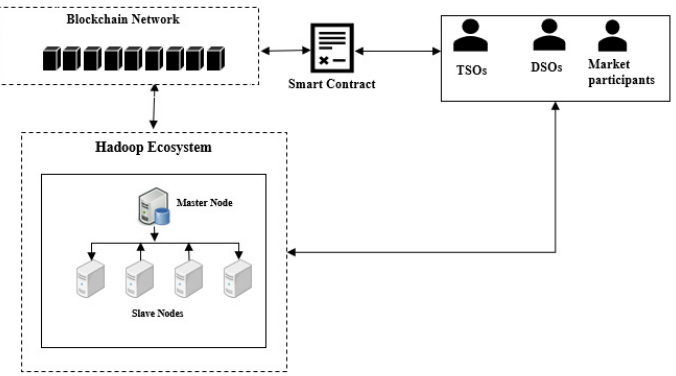
Figure 3. Architectural design of the blockchain-based approach for data exchange.